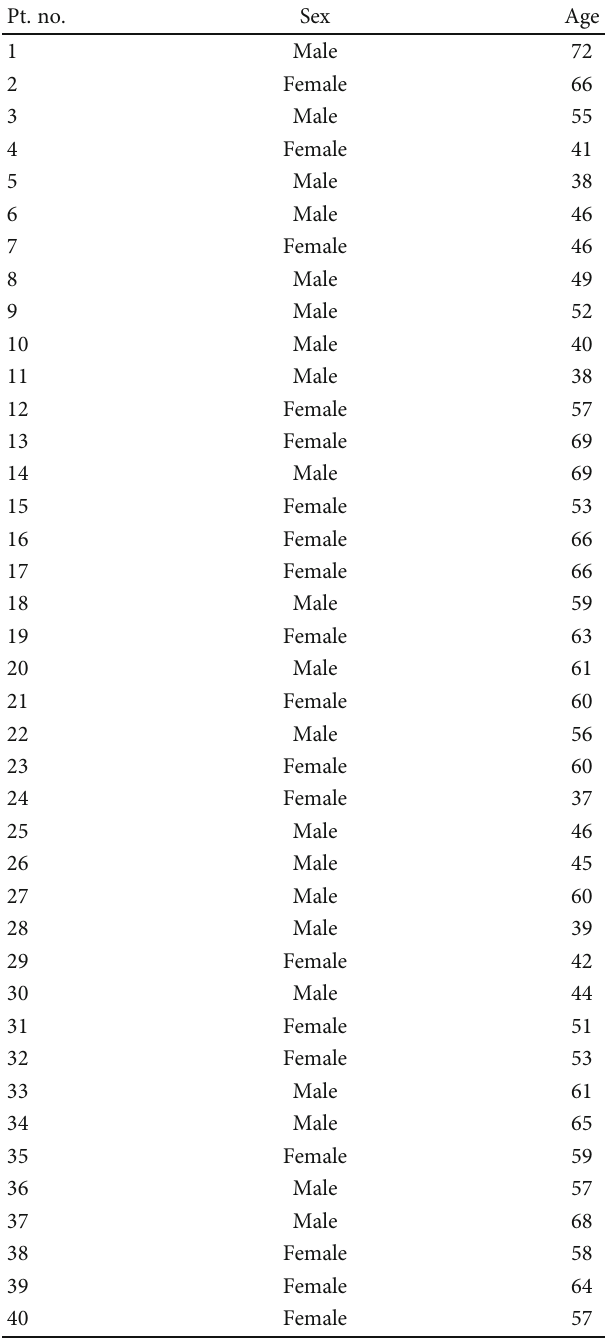
Table 1: Characteristics of